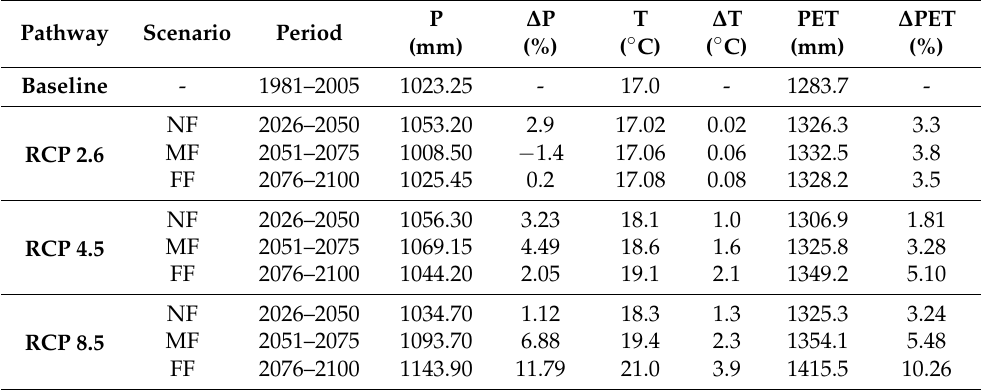
Table 4. Local climate change impacts analysis ensemble of CanESM2 and HadGem2-ES models for RCP 2.6, 4.5 and